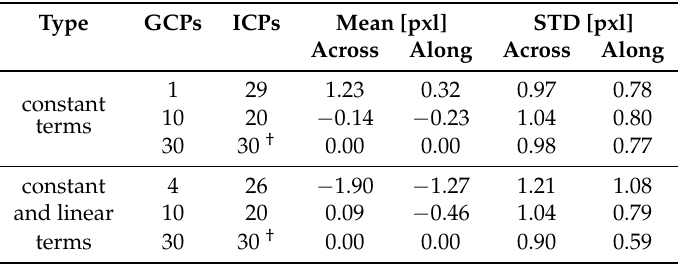
Table 4. 2D geo-location accuracy analysis using different adjustment settings for the image 1 of